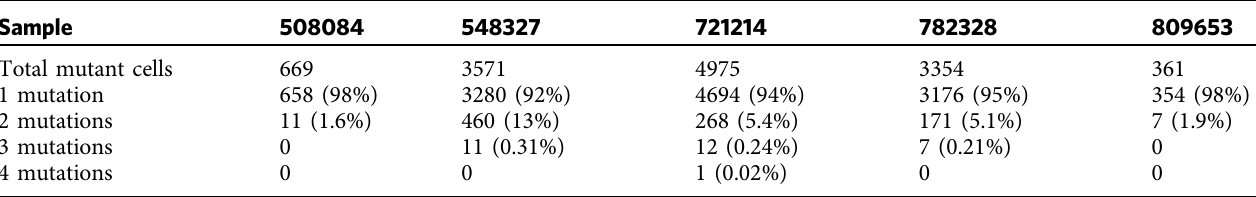
Revised Table 2. Frequency of cells containing multiple mutations in each